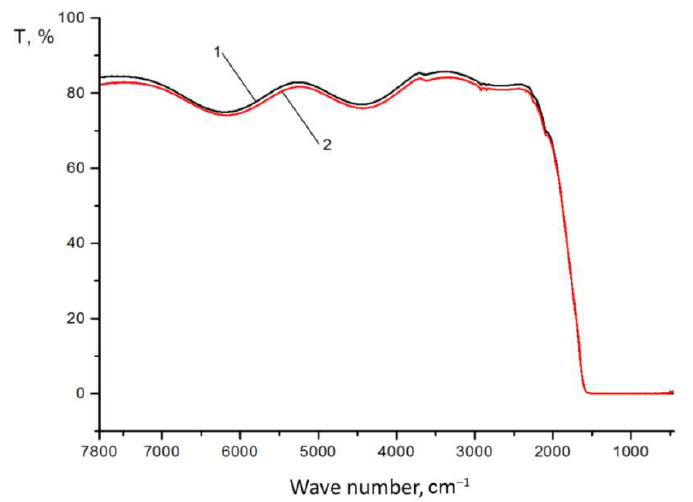
Figure 6. Optical transmittance in the infrared region of the spectrum of rounded samples 1 and 2 with interference Si–SiO coating, formed on a sapphire substrate with a diameter of 30 mm.